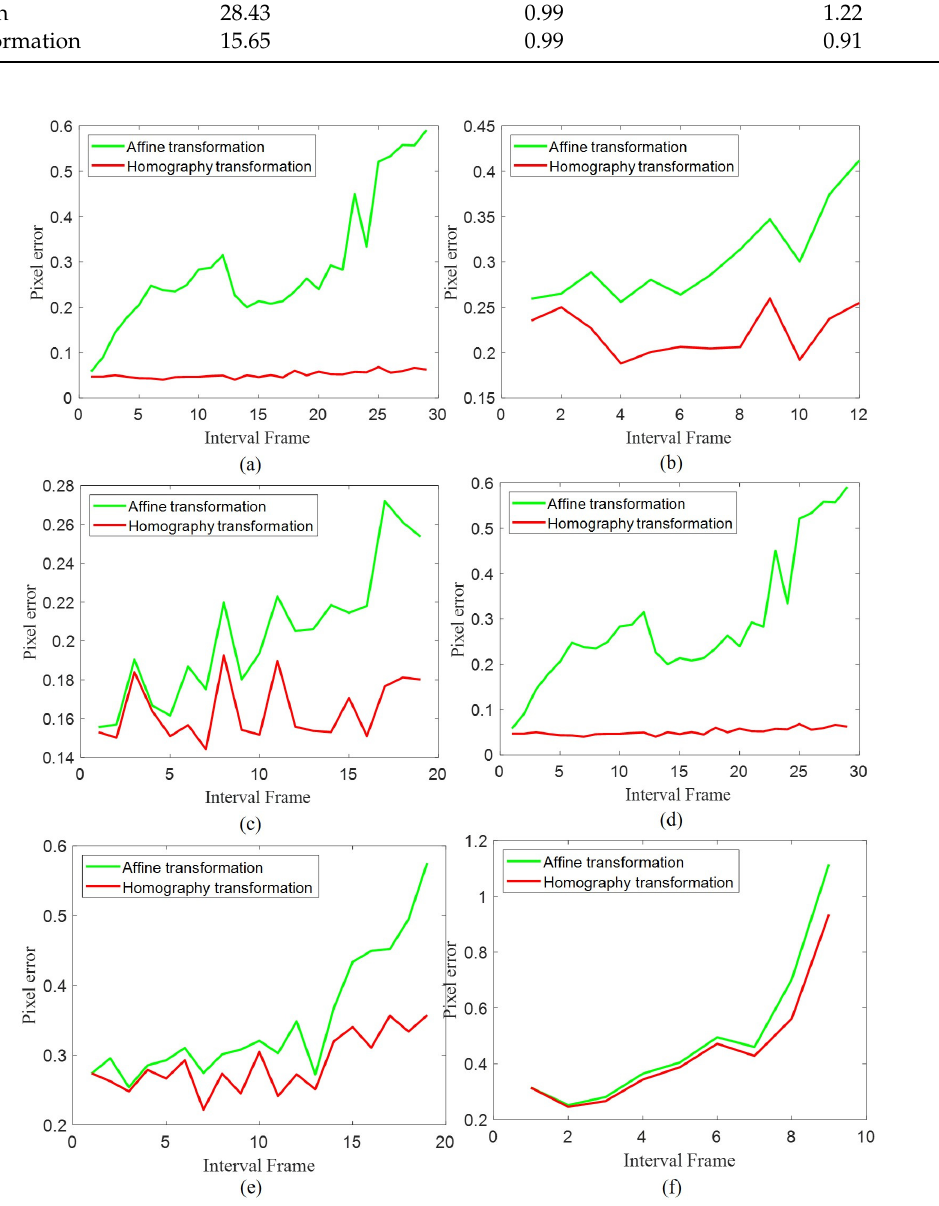
Figure 11. The error curve of difference transformation for matched points in ( a ) Seq.1, ( b ) Seq.2, ( c ) Seq.3, ( d ) Seq.4, ( e ) Seq.5, and ( f )